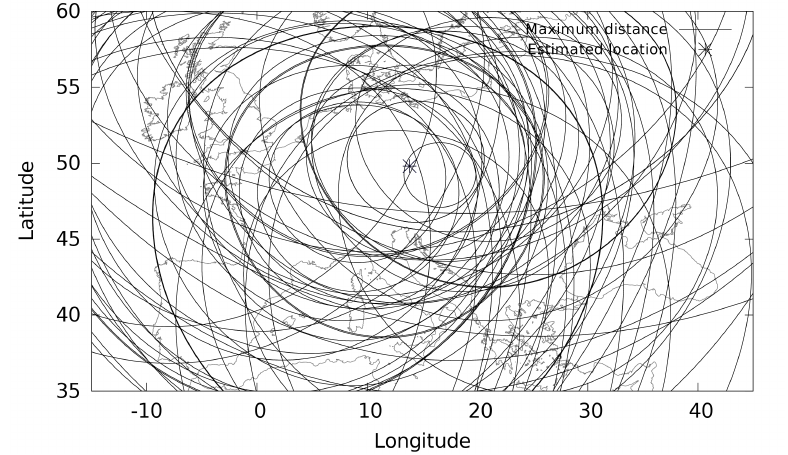
Figure 4. Used latency-based